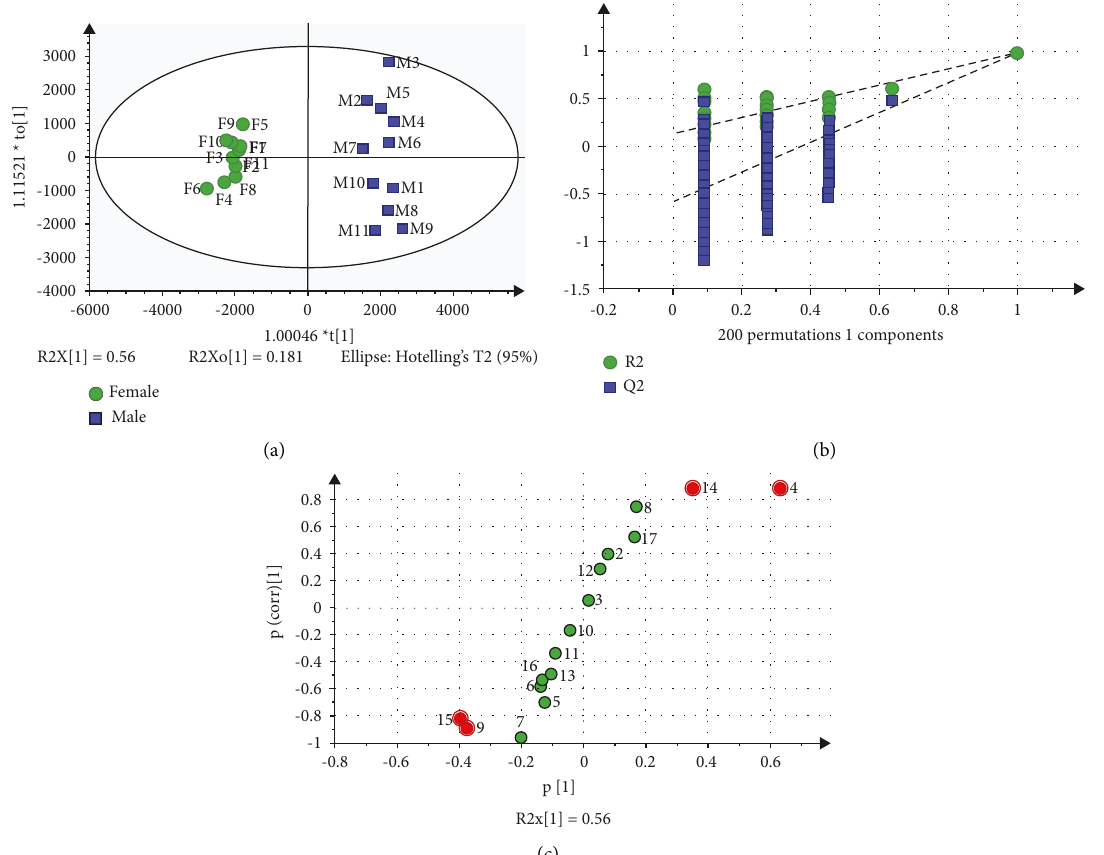
Figure 4: OPLS-DA model for the classification of MFB and FFB of P. tomentosa . (a) Score plot of the OPLS-DA model. Boxes refer to MFB of P. tomentosa , and circles refer to FFB of P. tomentosa . The X axis refers to the scores of PCs. The Y axis refers to the scores of orthogonal components. (b) 200 permutation tests of the OPLS-DA model. The X axis represents the correlation between the permuted model and the original model. The Y axis represents R 2 and Q 2 of the permuted models. (c) S -plot of the OPLS-DA model. The X axis represents the correlation coefficient between PCs and common compounds. The Y axis represents VIP